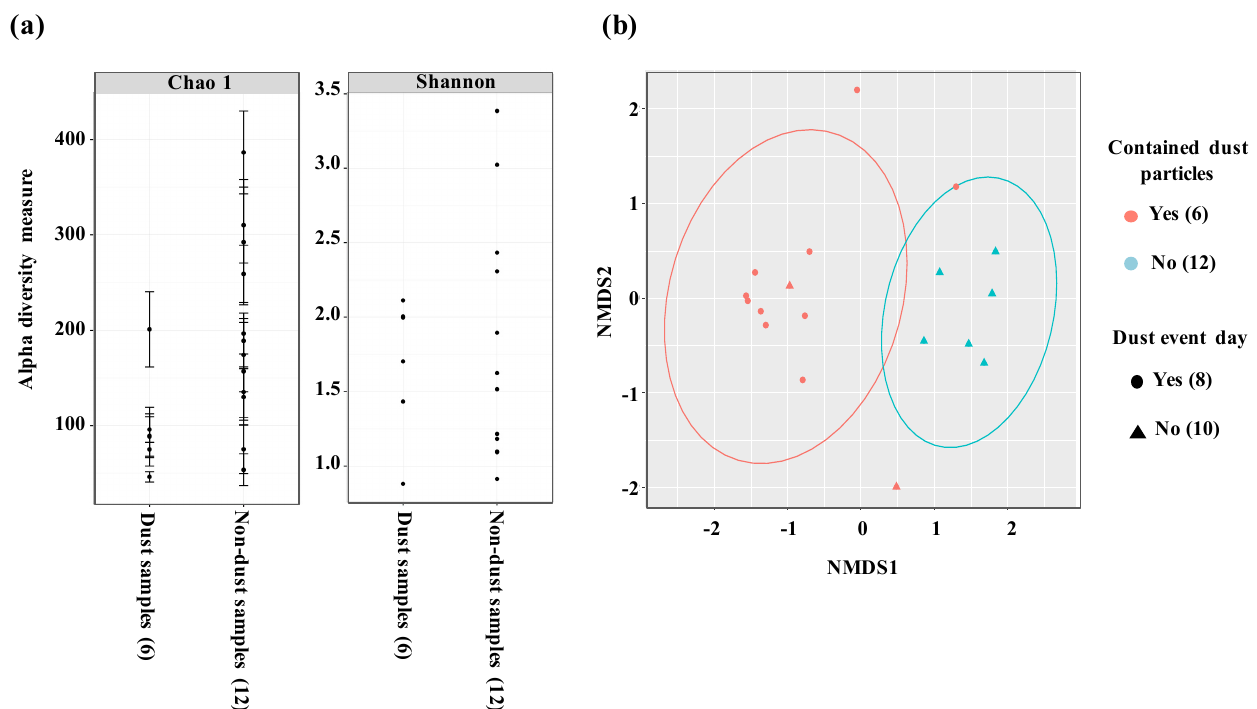
Figure 8. Comparison of the bacterial compositions among all air samples collected over the Noto Peninsula. (a) Box plots of Chao 1 and Shannon analyses indicating the bacterial diversity observed in dust samples and non-dust samples. Species were binned at the 97% sequence similarity level. (b) NMDS of the pairwise Bray–Curtis distance matrix displaying clustering by all the air samples. Red indicates the samples that were collected during dust events and blue indicates those collected during non-dust events as determined by meteorological data. Circles indicate that the sample contained dust particles as identified via microscopic observation, and triangles indicate that dust particles were absent from the sample. The confidence ellipses are based on a multivariate t distribution and represent the 95% confidence interval of the occurrence of dust vs. non-dust events when the samples were